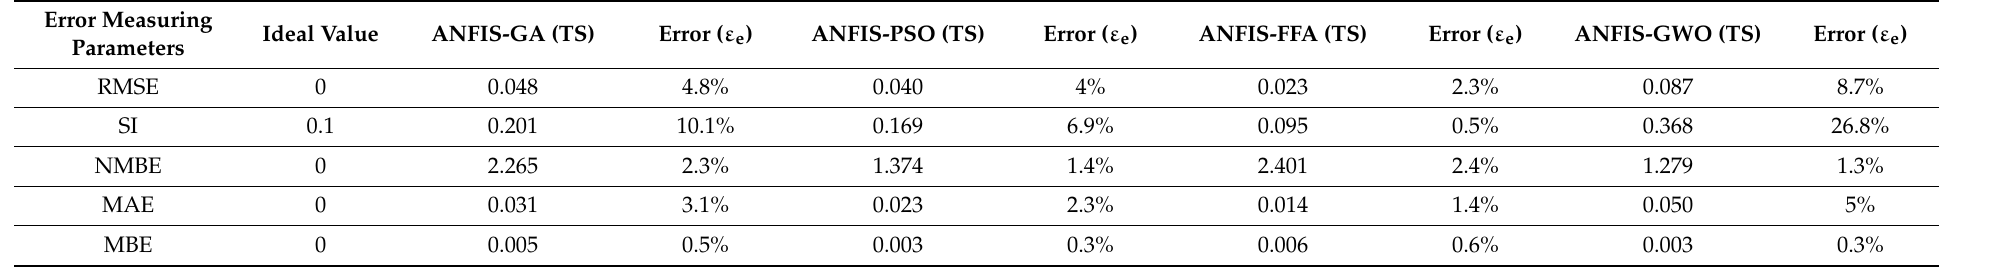
Table 7. Computed error for error measuring parameters (testing